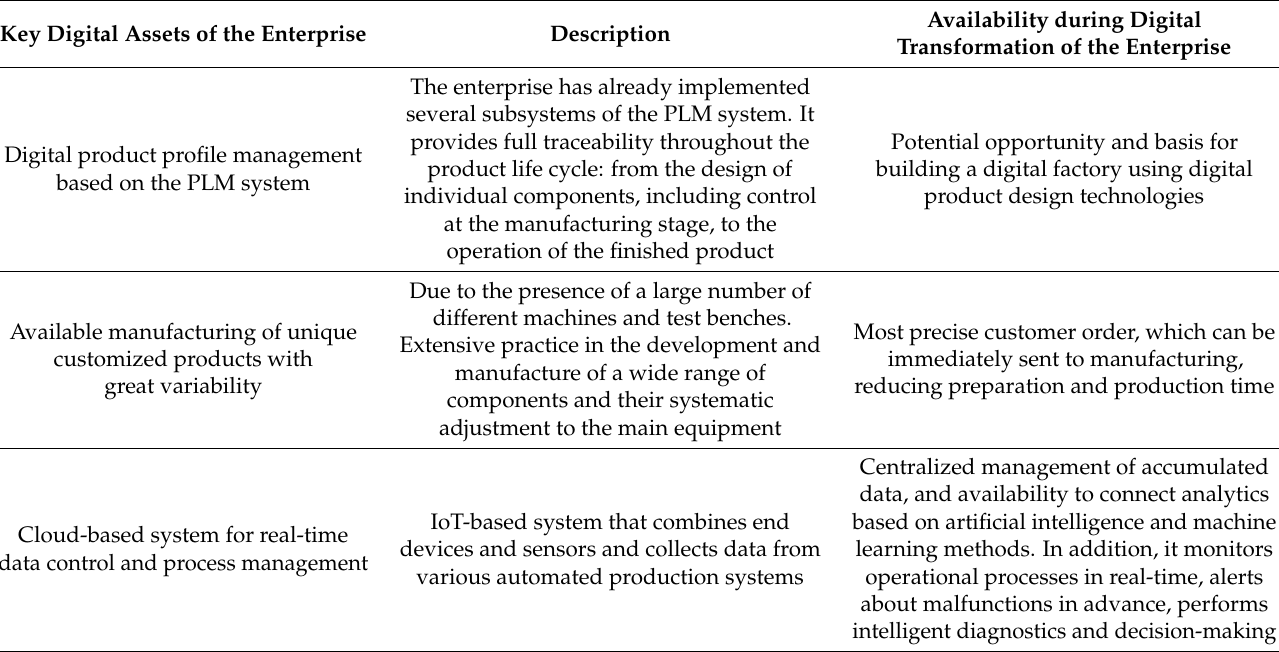
Table 2. Key digital assets of an instrumentation enterprise. Key Digital Assets of the